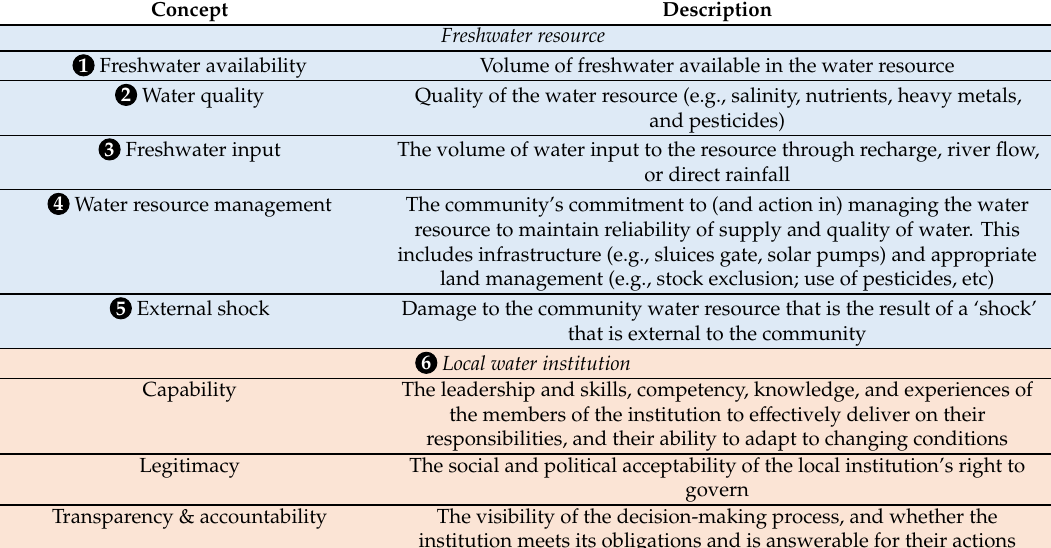
Table A1. A description of all the concepts mapped out in the local water management